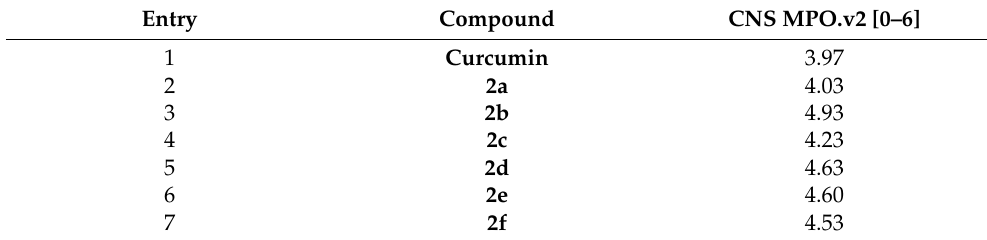
Table 2. Predicted CNS permeability of compounds 2